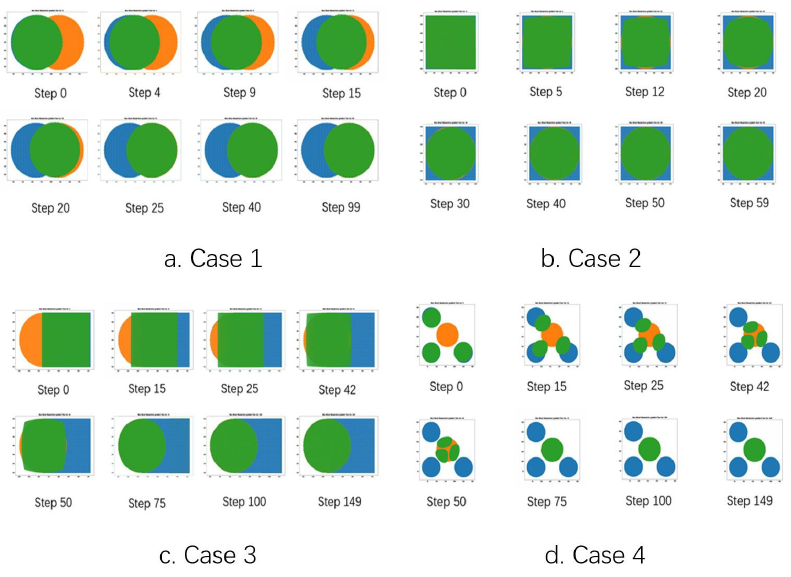
Figure 5. Transformation process of source distribution to target. In Case 1, the shapes of the two polygons are the same, and the max-sliced Wasserstein distance measures their difference in spatial position. When it goes to the 99th step, the initial distribution is transferred to the target distribution (the green circle moves to the same position as the orange